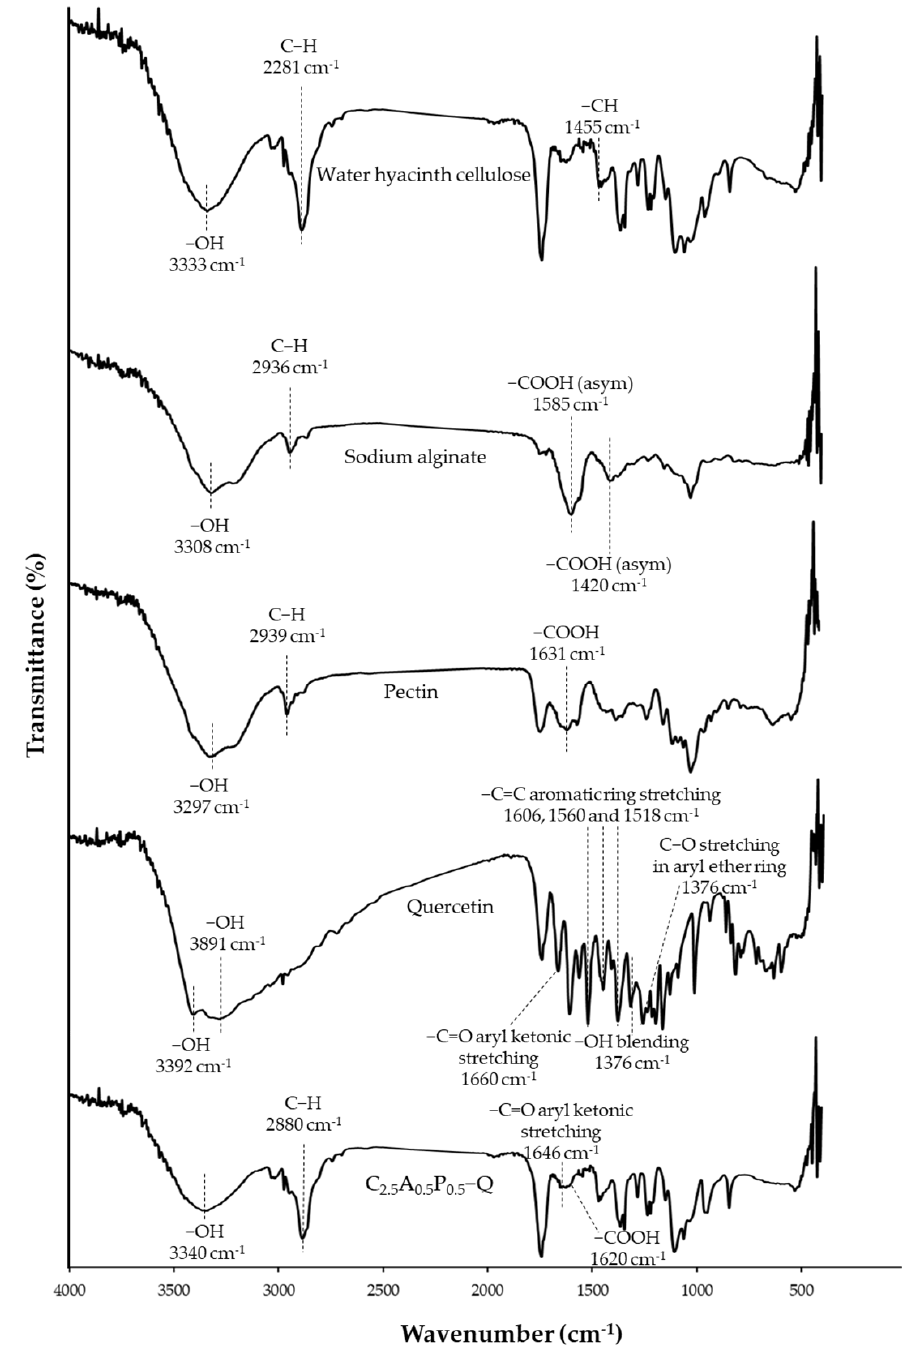
Figure 7. FTIR spectra of WHC-composited hydrogels. Upon visual inspection, the C 2.5 A 0.5 P 0.5 -Q was a regular shape with a yellow-green color due to the color of quercetin (Figure 8a). The thickness and diameter of C 2.5 A 0.5 P 0.5 -Q were 5.15 ± 0.17 and 44.33 ± 0.82 mm, respectively. The SEM micrograph showed a slightly rough surface of C 2.5 A 0.5 P 0.5 -Q (Figure 8b). In the cross-sectional observation, the C 2.5 A 0.5 P 0.5 -Q showed numerous porosities in the hydrogel’s matrix, similar to the hydrogel without quercetin (C 2.5 A 0.5 P 0.5 ) (Figure 8c). Interestingly, the puncture strength significantly increased from 2.16 ± 0.14 to 2.50 ± 0.10 N/mm 2 due to hydrogen bonding between WHC and quercetin, enhancing the hardness of the hydrogel ( p <